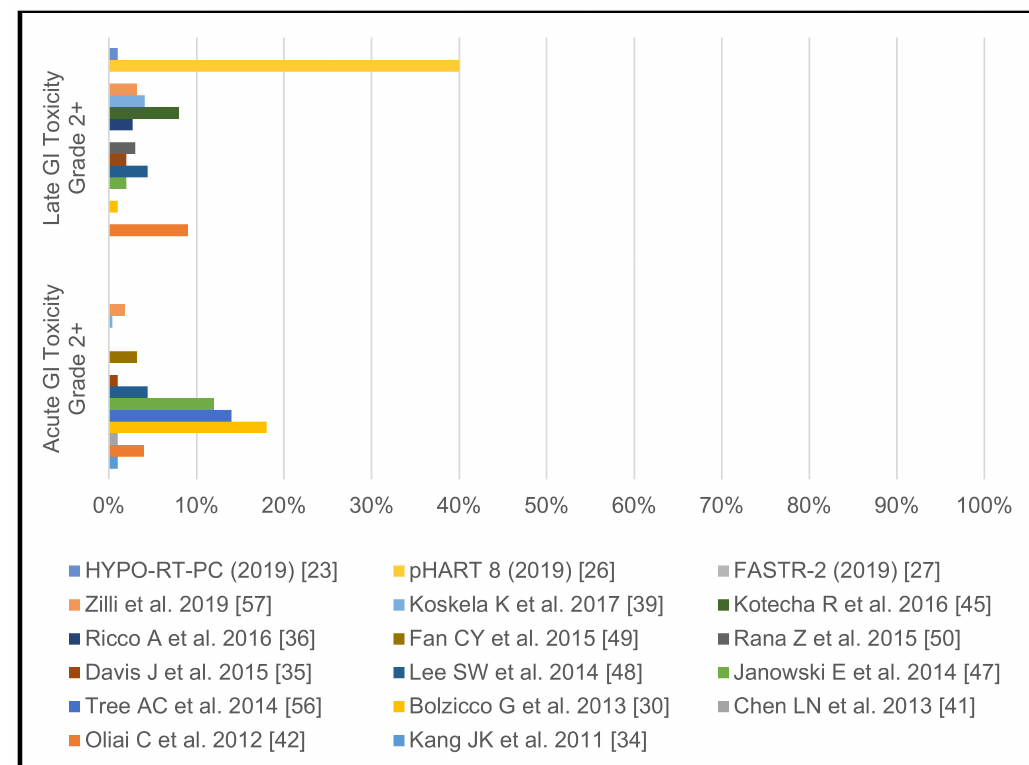
Figure 5. Acute and late gastrointestinal toxicity rates grades >/= 2 in studies without pelvic lymph node